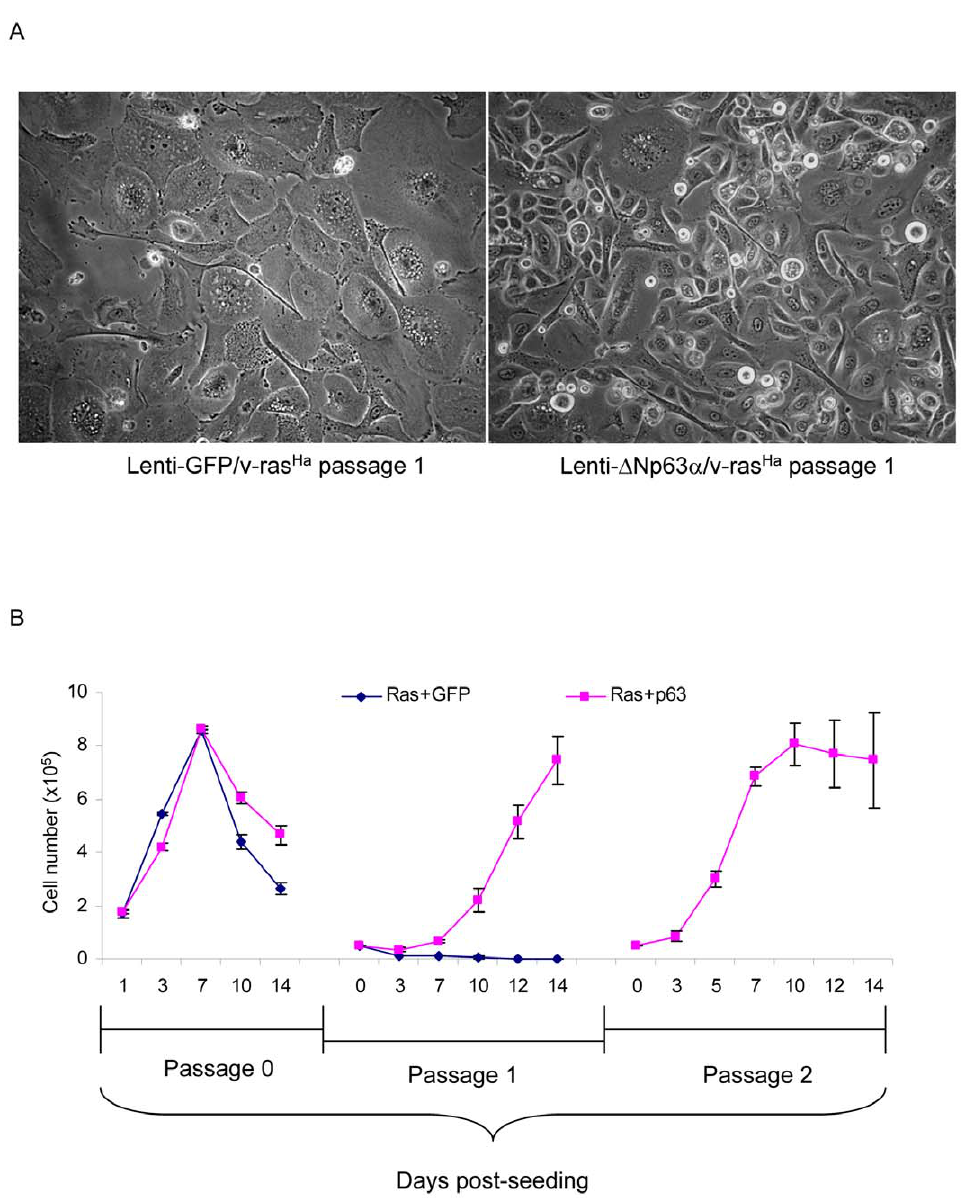
Figure 6. Overexpression of D Np63 a supports long term survival of v-ras Ha -expressing primary keratinocytes. Primary keratinocytes were infected sequentially with retrovirus encoding oncogenic v-ras Ha and lentivirus encoding GFP or D Np63 a , as noted. On post-infection day 14, the cells were trypsinized and reseeded. A, cell morphology was recorded at day 3 after the initial reseeding. B, growth curves of keratinocytes expressing v-ras Ha in conjunction with lenti-GFP or lenti- D Np63 a . Cell numbers were counted at days 1, 3, 7, 10 and 14 post-lentivirus infection (passage 0), or at the same timepoints following each reseeding. Data are expressed as cell number per well and represent the means 6 S.D. of two independent